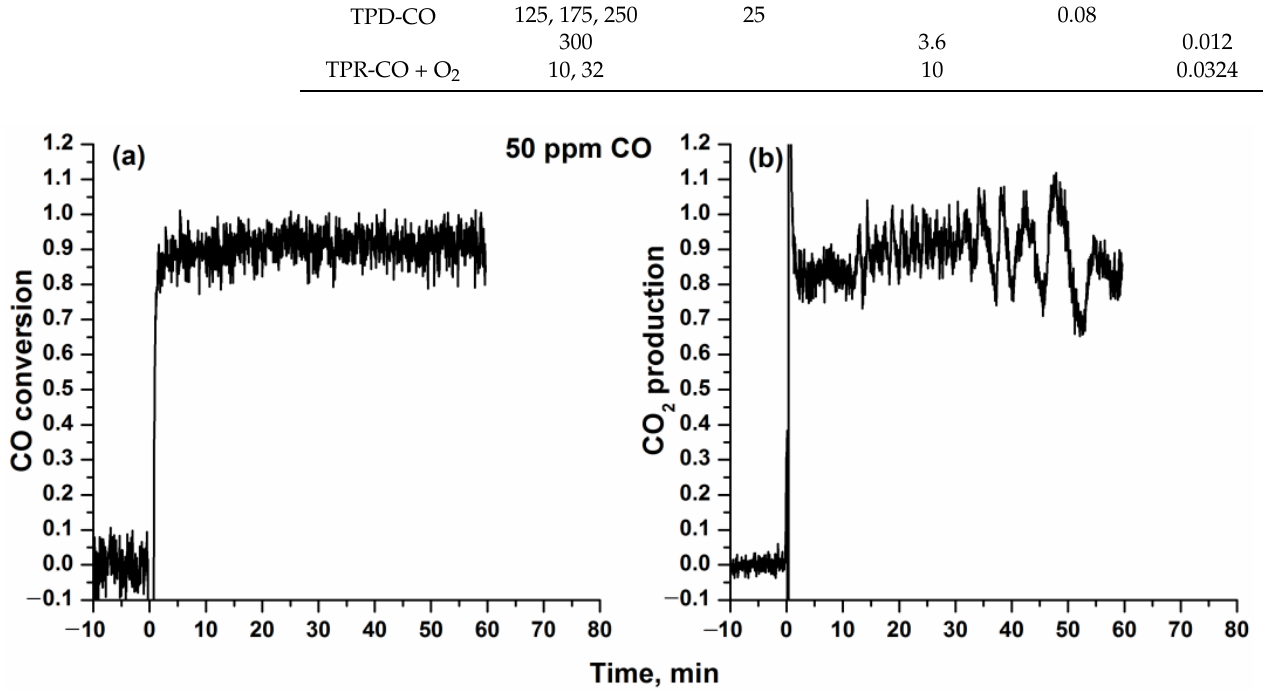
Figure A1. ( a ) CO conversion and ( b ) CO 2 production versus time for an experiment with initial CO concentration of 50 ppm at 25 °C.